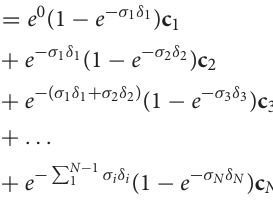
FIGURE 3 | A sketch of how a ray is integrated through the scene representation. The main region of interest is surrounded by a voxel grid. This grid is hierarchichally surrounded by environment maps, their distance increasing with the square of the distance to the voxel grid. First, an intersection test is made between the ray and the grid to get the entry and exit points. While in the volume, the ray is raymarched using jittered steps. Upon exit, the ray is successively intersected with the environment maps in order. Intersection tests are marked with an x and raymarch steps with a